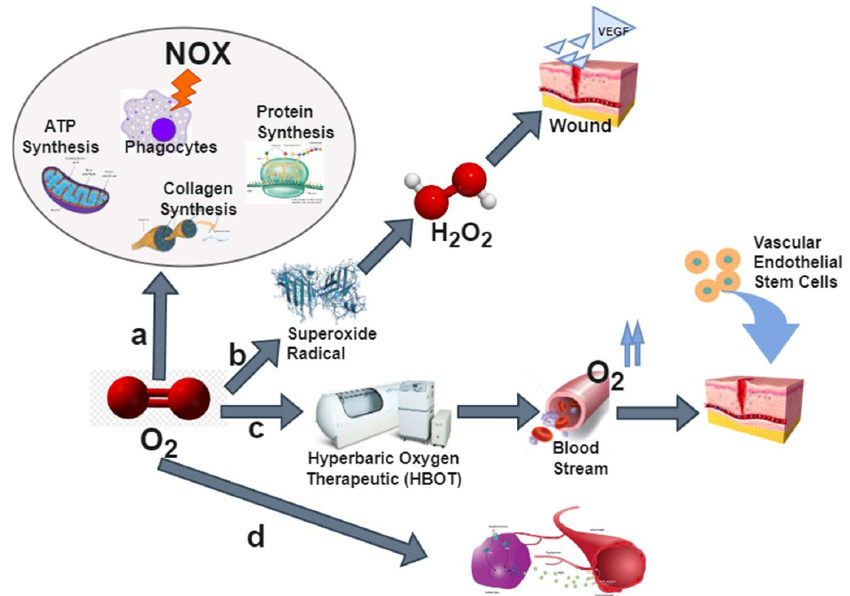
Figure 1. Oxygen repair cell derivation process. ( a ) Synthesis of adenosine triphosphate (ATP), collagen, protein, phagocytes, and oxygen. ( b ) Enzyme-catalyzed redox repair in the cell. ( c ) Hyperbaric oxygen therapeutic cell repair. ( d ) Synthesis of nitric oxide (NO) angiogenesis. Vascular endothelial growth factor (VEGF)